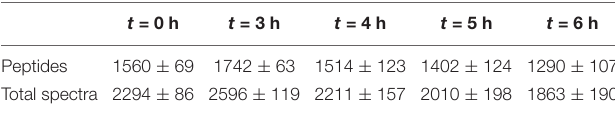
TABLE 2 | Summary of peptide identification during growth of S. thermophilus N4L in a YE-based